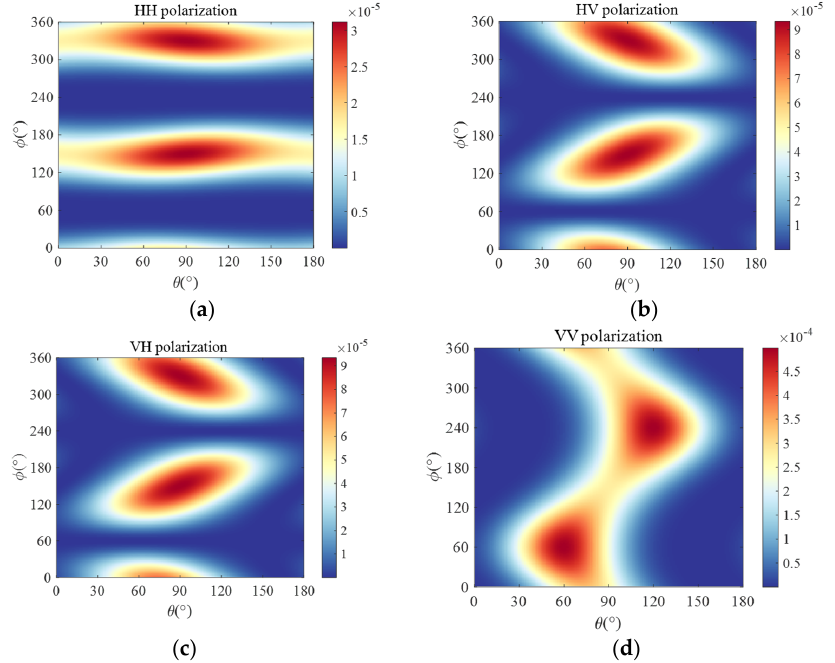
Figure 4. Angular distribution of the chaff RCS for different polarizations. ( a ) HH; ( b ) HV; ( c ) VH; ( d ) VV.